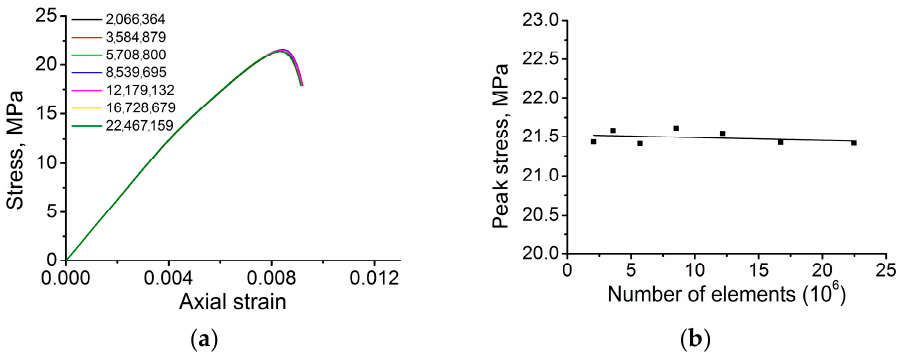
Figure 4. Verification of the numerical solution convergence: ( a ) stress-strain curves for models with different number of mesh elements, ( b ) peak stress of obtained stress-strain curves against the number of mesh elements.